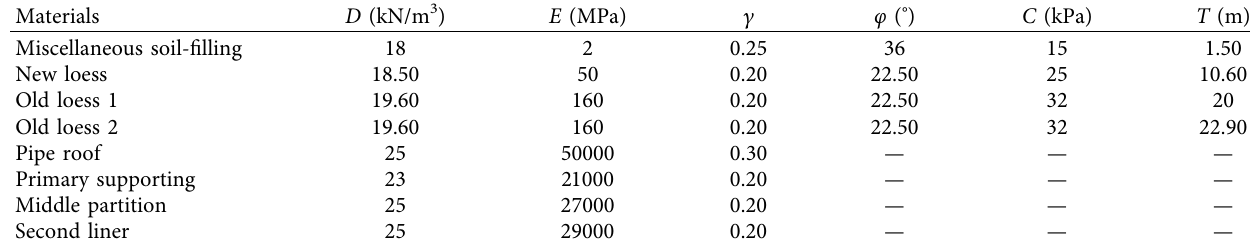
Table 1: Physical and mechanical parameters of materials.